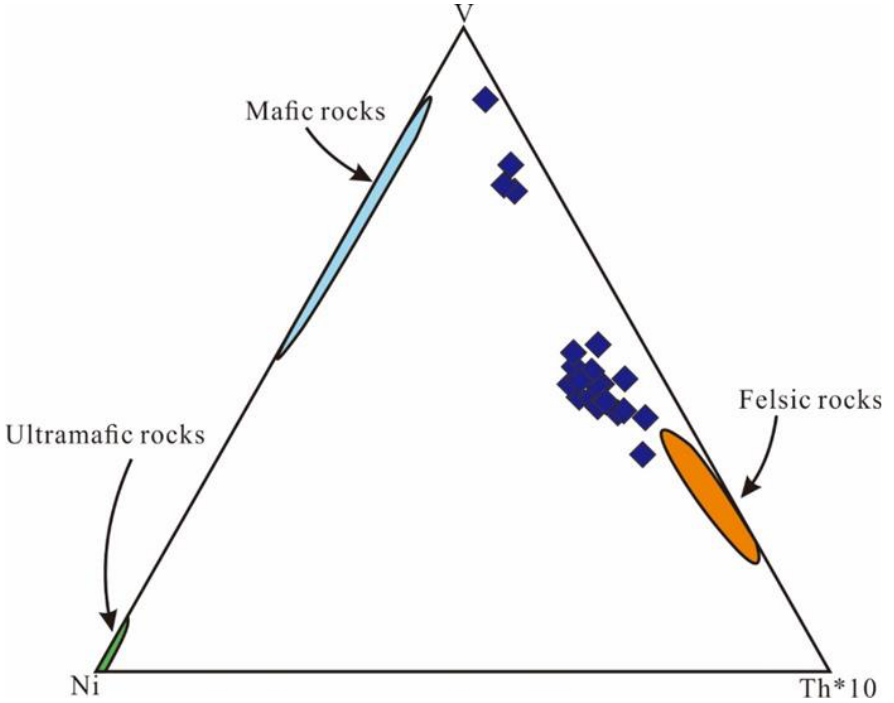
Figure 11. Ni-V-Th*10 ternary diagram for provenance discrimination of the Zhiluo Formation sandstones [46].